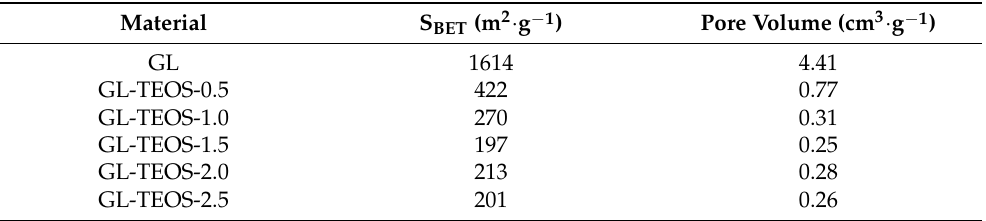
Table 2. The specific surface areas investigated by Brunauer–Emmett–Teller (BET) (S BET ) and pore volume of GL and GL-TEOS-x (x = 0.5, 1, 1.5, 2, and 2.5).